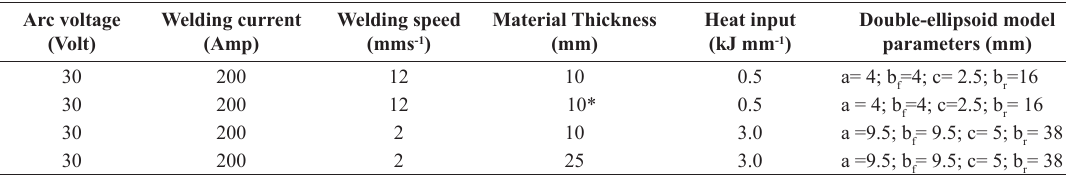
Table 2. Welding and double-ellipsoid model parameters Arc voltage